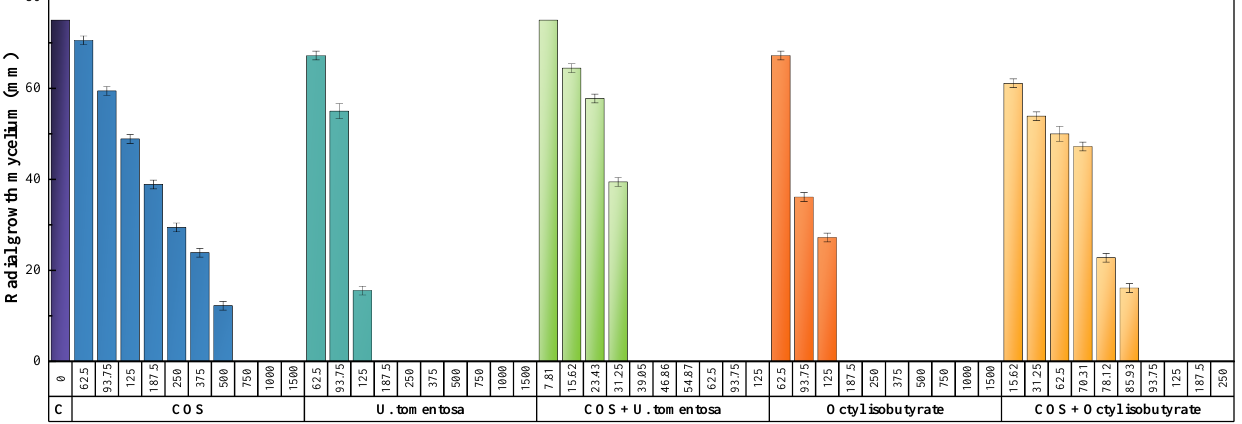
Figure 4. Inhibition of radial growth of the mycelium of P. cactorum in in vitro assays performed with different concentrations (in the 7.81 – 1500 µg·mL −1 range) of chitosan oligomers (COS), extract of U. tomentosa bark, the main constituent of the extract, and their respective conjugated complexes. Error bars represent standard deviations.